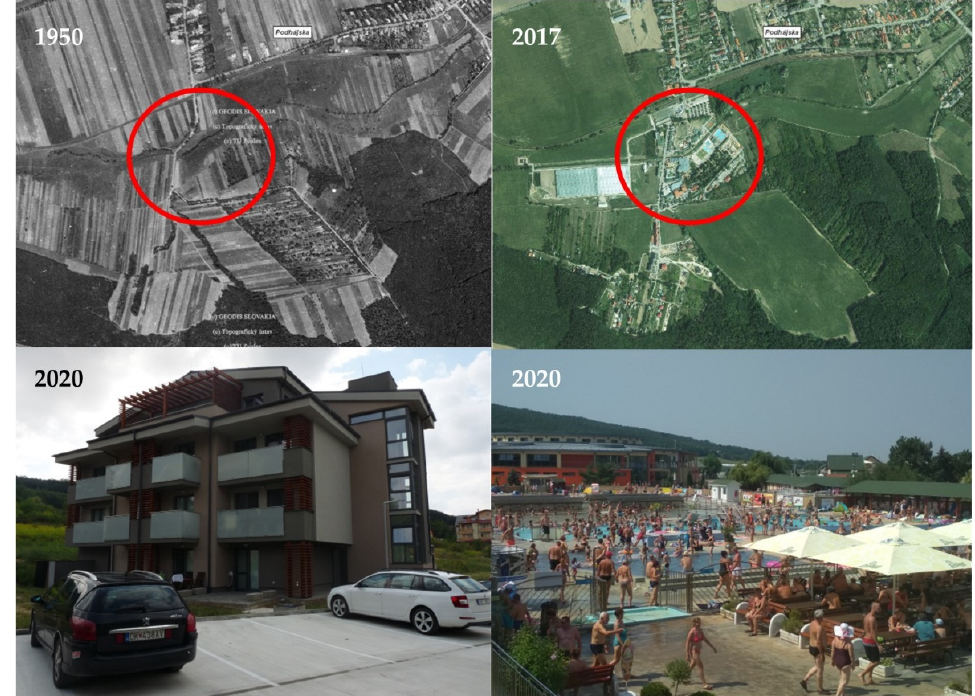
Figure 7. Visual interpretation of the Podhájska site. Source: 1950—Adapted with permission from ref. [37]. Copyright 2021 GEODIS SLOVAKIA, s.r.o. Bratislava, Topografický ústav Banská Bystrica. 2017—Adapted with permission from ref. [38]. Copyright 2021 GKÚ Bratislava, NLC Zvolen. 2020—